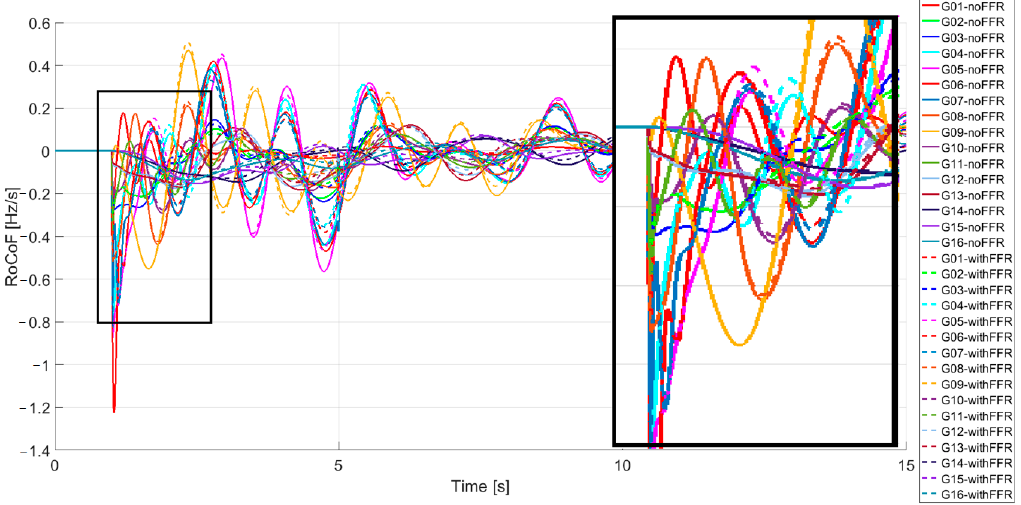
Figure 21. Frequencies at generator buses after disturbance in Area 1.